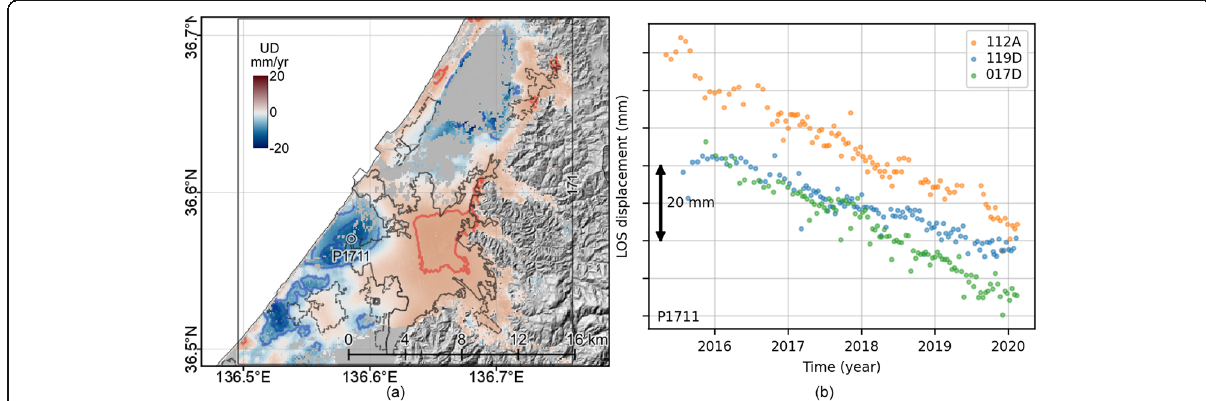
Fig. 5 a Vertical deformation velocities in Kanazawa (ID: 171). The black lines denote the outlines of the DID. The interval of the red (uplift) and blue (subsidence) contour lines is 5 mm/year without the 0 mm/year lines. The black square denotes the reference point. b LOS deformation time series at P1711 for each frame